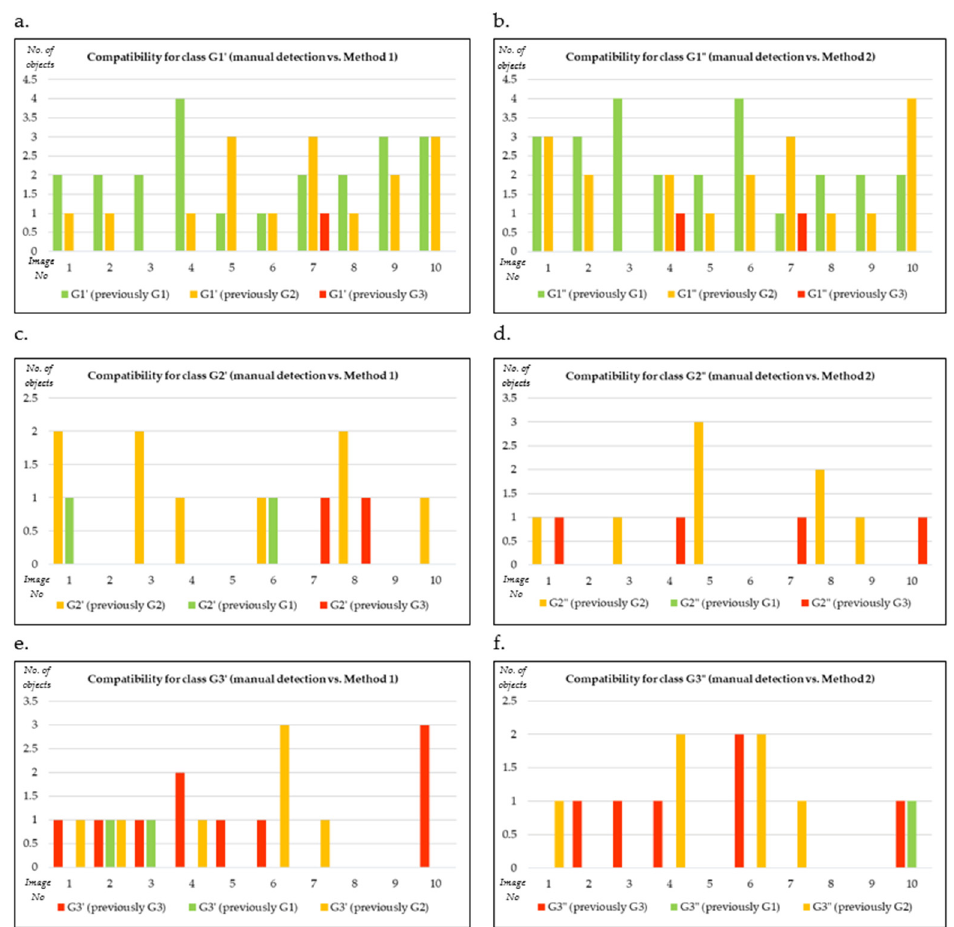
Figure 15. Compliance results of classification groups: ( a , c , e ) comparison of the results from Method 1 and manual detection; ( b , d , f ) comparison of the results from Method 2 and manual detection.